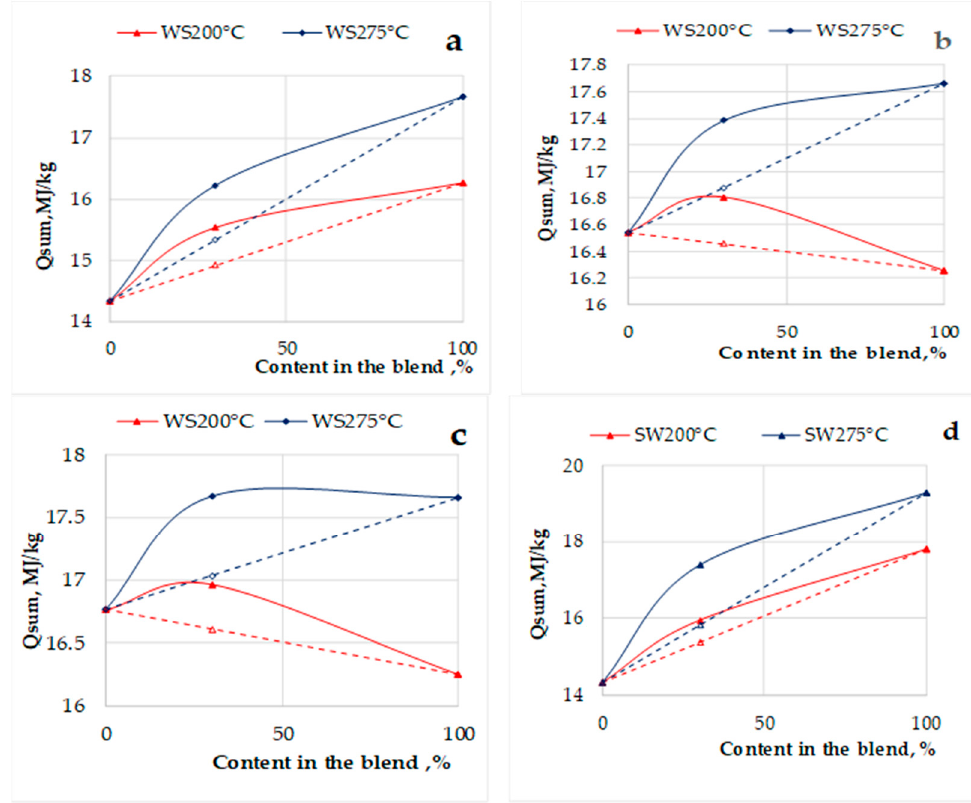
Figure 6. The heat output from the pilot device (TRL 5) in the result of combustion of binary blends containing 30% of biomass pellets previously pretreated at 200 and 275 °C and 70% of non-treated pellets: MW pre-treated WS +WS n.t. ( a ); MW pre-treated WS +SW n.t. ( b ), MW pre-treated WS +Peat ( c ); MW pre-treated SW+WS n.t.( d ). The linear dependence is marked by dashed lines.